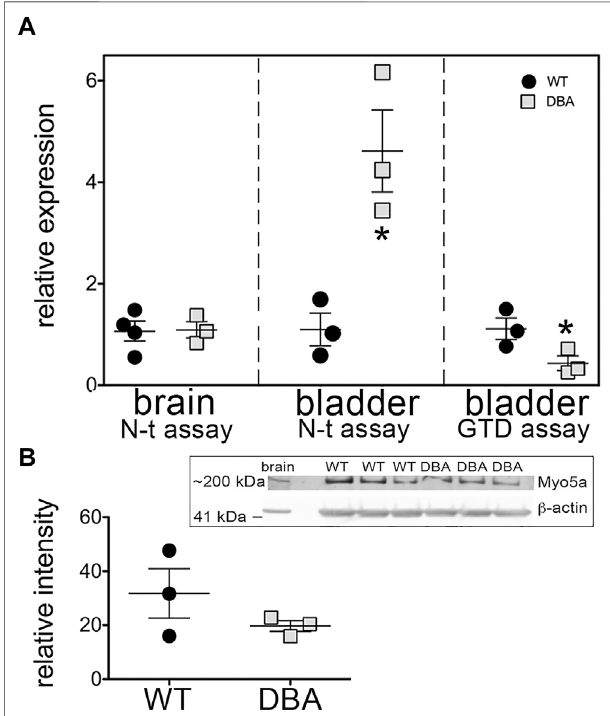
FIGURE 3 | Overall Myo5a expression in bladder. (A) cDNA from brains anddetrusorsofWT(blackcircles, N =3)andDBAanimals(graysquares, N = 3) was assayed in triplicate for the two different pan-Myo5a RT-PCR primer/ probe sets indicated, and for 18S rRNA as internal control. Expression was determined by the ΔΔ Ct method and graphed relative to WT within each organ. Comparison of WT vs. DBA brain was not signi fi cant ( p = 0.67), but of WTvs.DBAdetrusorwassigni fi cantlyhigherfortheN-terminal(N-t)assayand lower for the globular tail domain (GTD) assay (* p < 0.05). (B) Representative immunoblot (inset box) and quantitative graph showing the expression of Myo5a protein in lysates from WT (black circles, N = 3) and DBA detrusors (gray circles, N = 3). 30 µg aliquots of detrusor extracts were immunoblotted with Myo5a antibody (LF-18). Brain extract was loaded in lane 1 as a positive control. When intensities of the ~200 kDa Myo5a band were corrected for intensities of the 42 kDa ß-actin loading control, WT and DBA Myo5a protein levels were not signi fi cantly different ( p = 0.4).